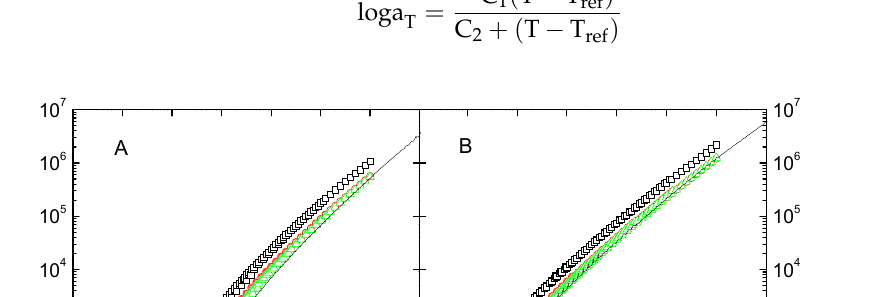
Figure 5. Black diagrams (phase angle, δ, versus complex shear modulus, G*) of neat bitumen, before and after ageing by RTFOT and RTFOT + PAV.